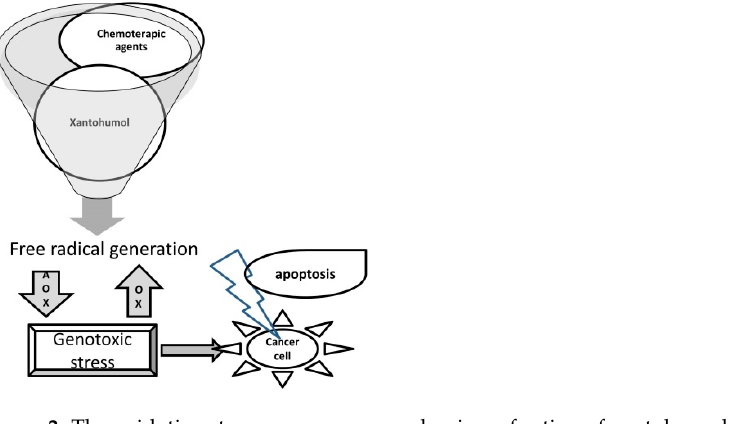
Figure 3. The oxidative stress: a common mechanism of action of xantohumol and chemotherapeutics on cancer cells.